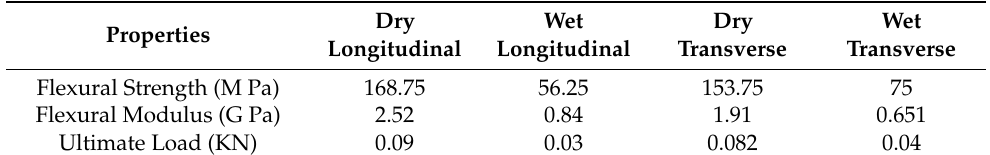
Table 6. Flexural properties of Deccani sheep horn.